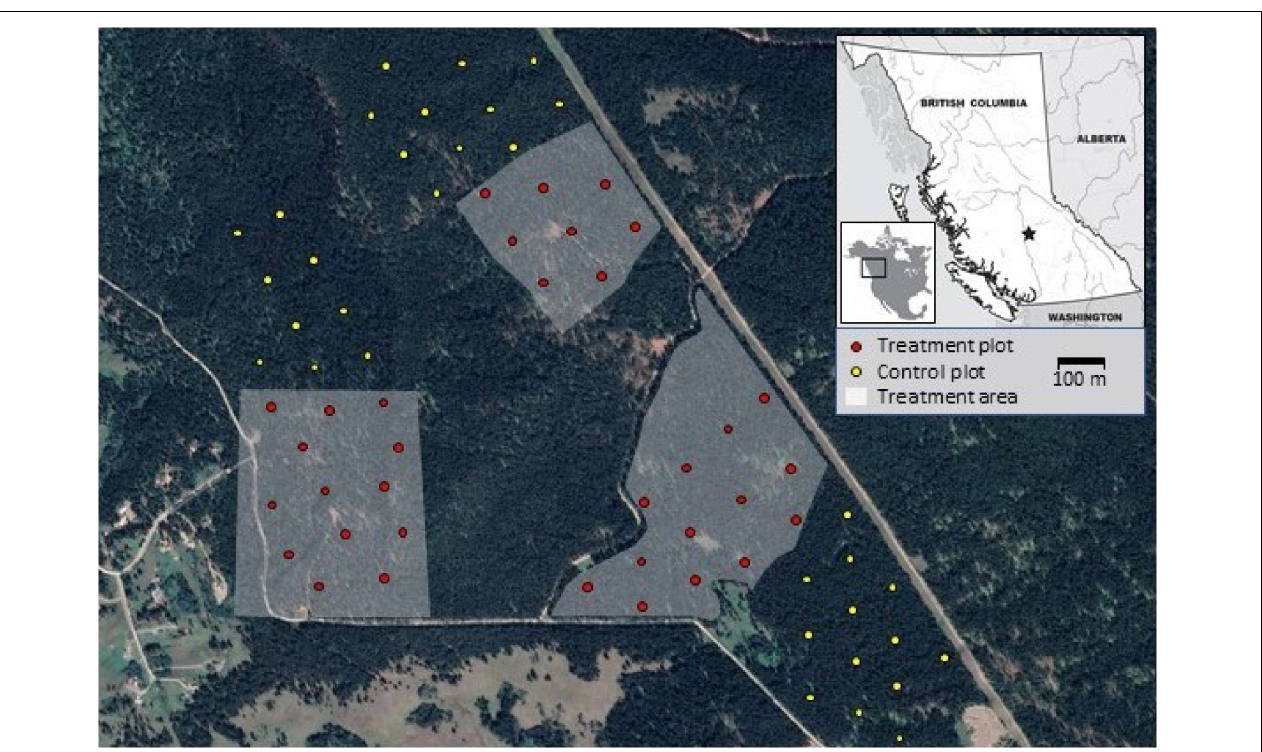
FIGURE 1 | Location of 33 control and 34 treatment plots in the Knife Creek portion of the Alex Fraser Research Forest in central British Columbia,